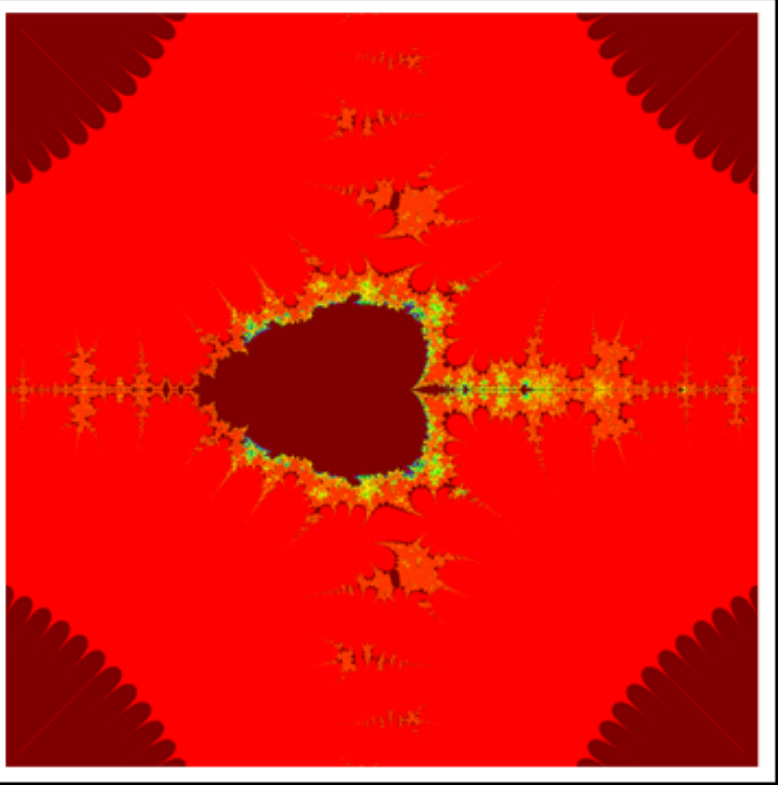
Figure 25. M-set for τ ( z ) = sin ( z 2 ) + c via DKIS. The image execution time is 404.594